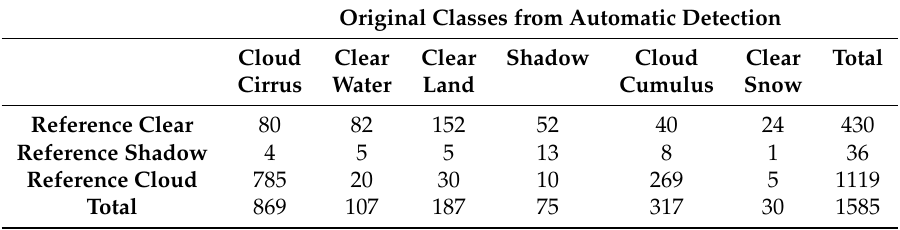
Table 4. Cross-tabulation between visually interpreted reference classes (1585 samples) and the initial classes from automatic cloud and shadow detection, before combination into the tree target